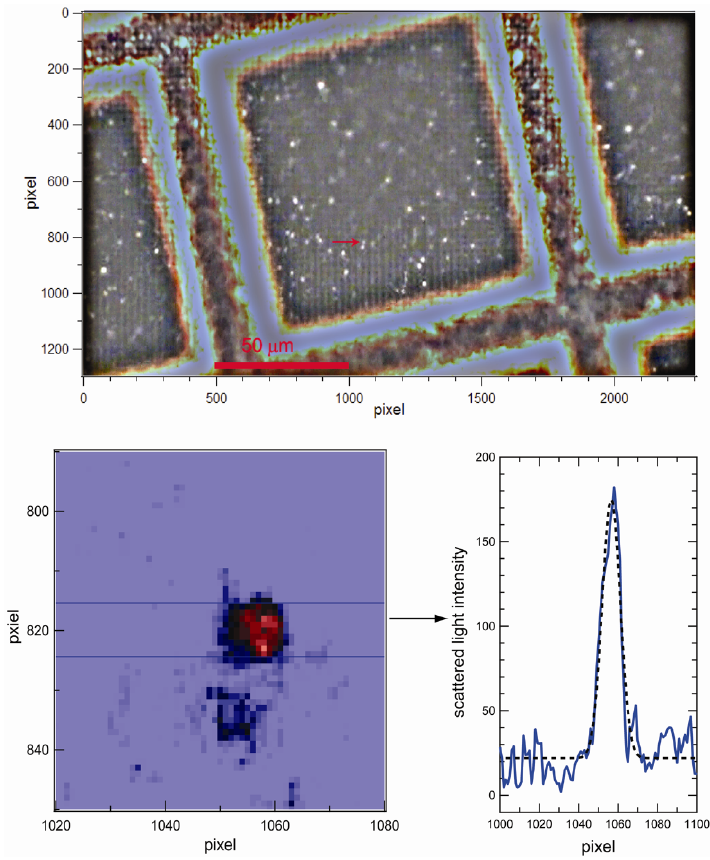
Fig. 5. Illustration of fast framing at 240 frames/second using the 50X objective. Only the consecutive frame is shown (top). The optical image size is 230.4µm by 129.6µm. A single 100nm particle arrived between the two frame indicated by a red arrow. The bottom left panel depicts the difference photo of this particle. The profile of this particle is defined by two blue lines. Its scattered light intensity is depicted in the bottom right panel. A Gaussian fit (shown in the dashed line) is used to determine the peak height, width, center, and baseline.